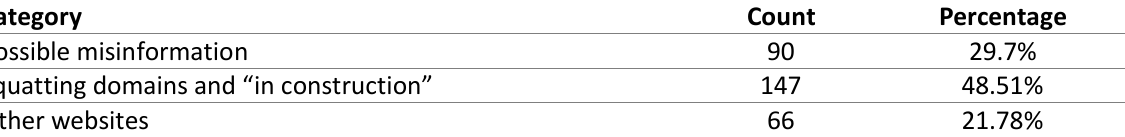
Table 2. Misinformation candidate websites in data